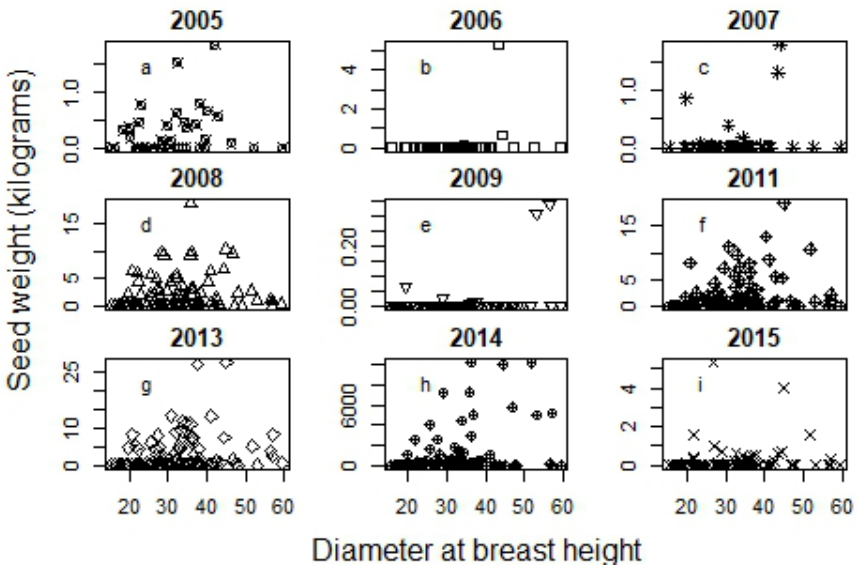
Figure 2. Annual seed production (kilograms) by Carapa guianensis diameter at breast height in Acre Brazil in ( a ) 2005; ( b ) 2006; ( c ) 2007; ( d ) 2008; ( e ) 2009; ( f ) 2011; ( g ) 2013; ( h ) 2014; and ( i ) 2015.